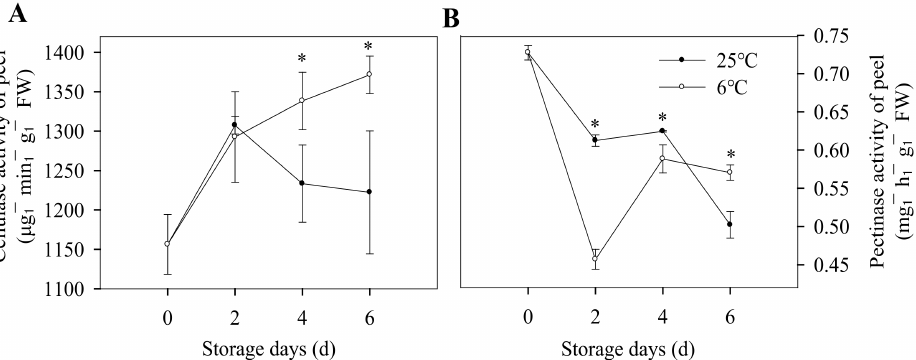
Figure 5. Changes of enzyme activity related to cell wall degradation of banana fruit during storage at 6 ◦ C and 25 ◦ C. Cellulase activity ( A ) and pectinase activity ( B ) of banana peels during storage. Each data point represents a mean ± standard error ( n = 3). ‘*’ means a significant difference between control and experimental fruit at 5%